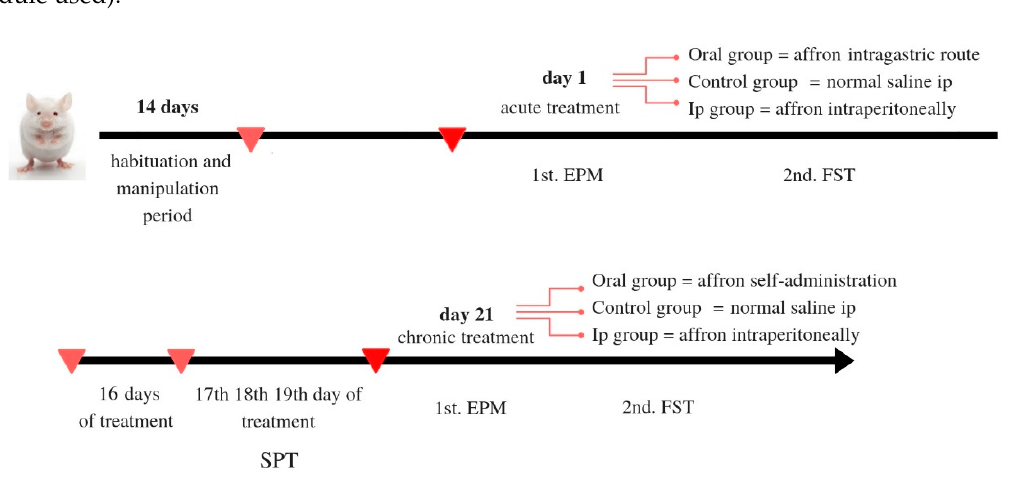
Figure 4. Schematic representation of the treatment schedule.